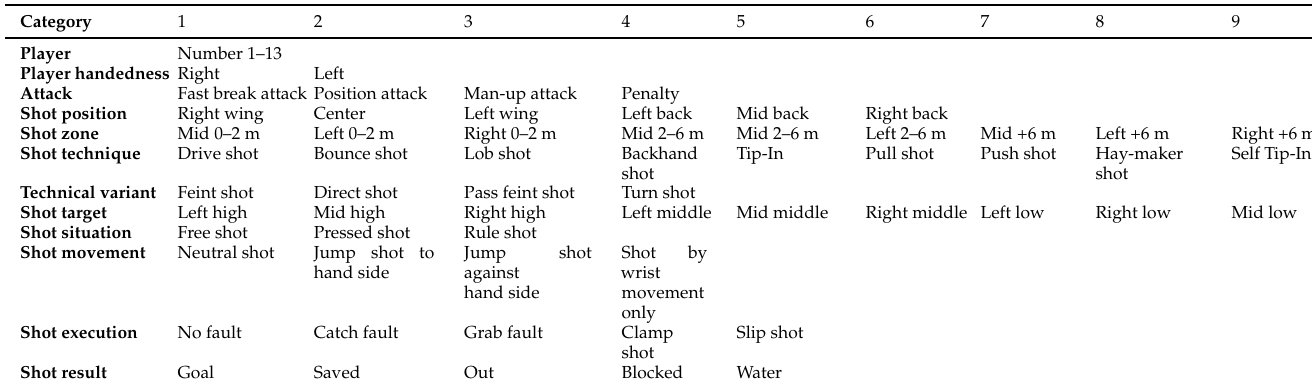
Table 1. Observed categories (and its different characteristics) of goal shot behavior in the water polo World Cup 2018 in